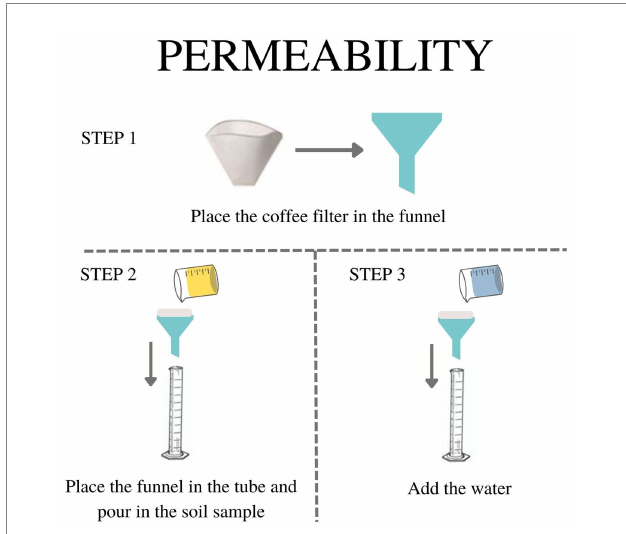
FIGURE 2 Example of a pictographic scheme representing the materials and the sequence of the experimentation